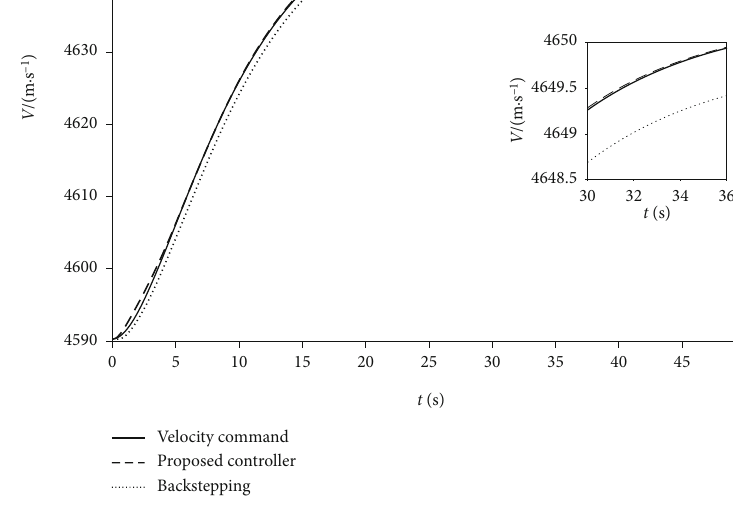
Figure 4: Velocity